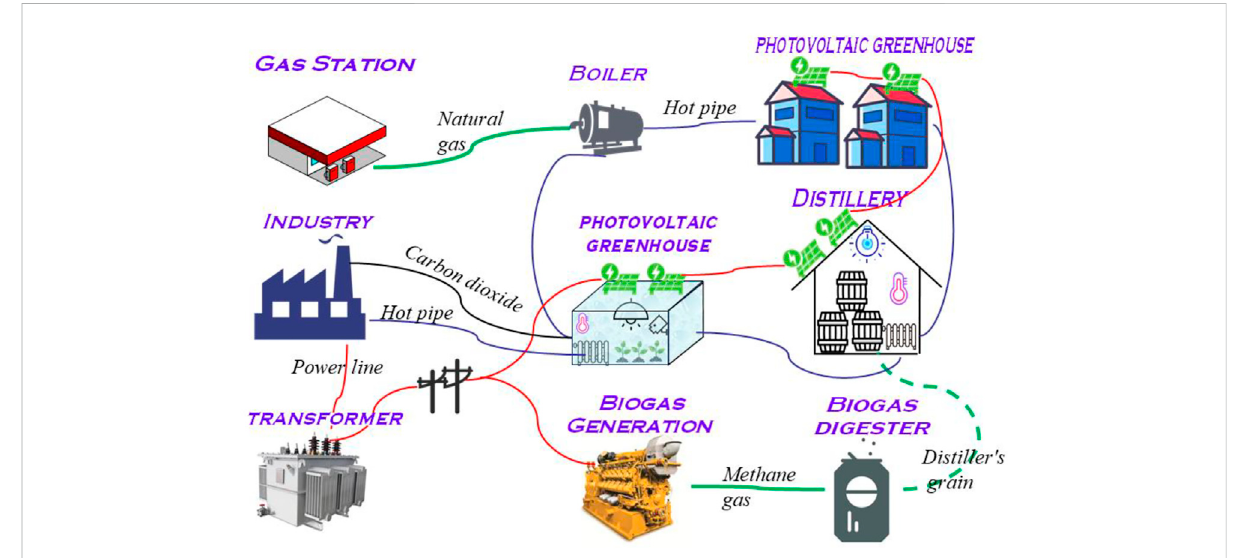
FIGURE 1 Schematic diagram of the rural IES in Qingdao,